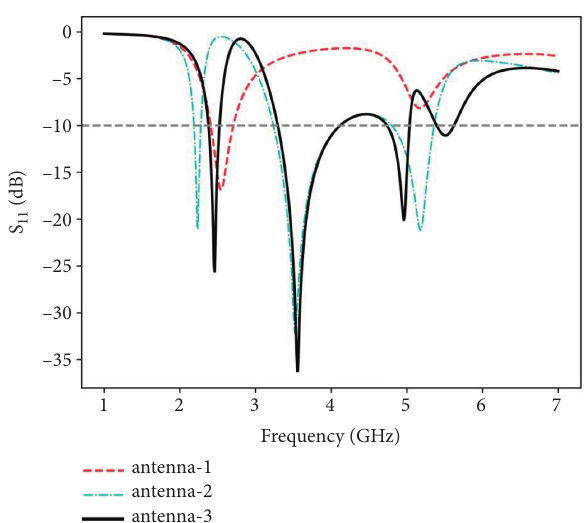
Figure 3: Simulated reflection coefficients S